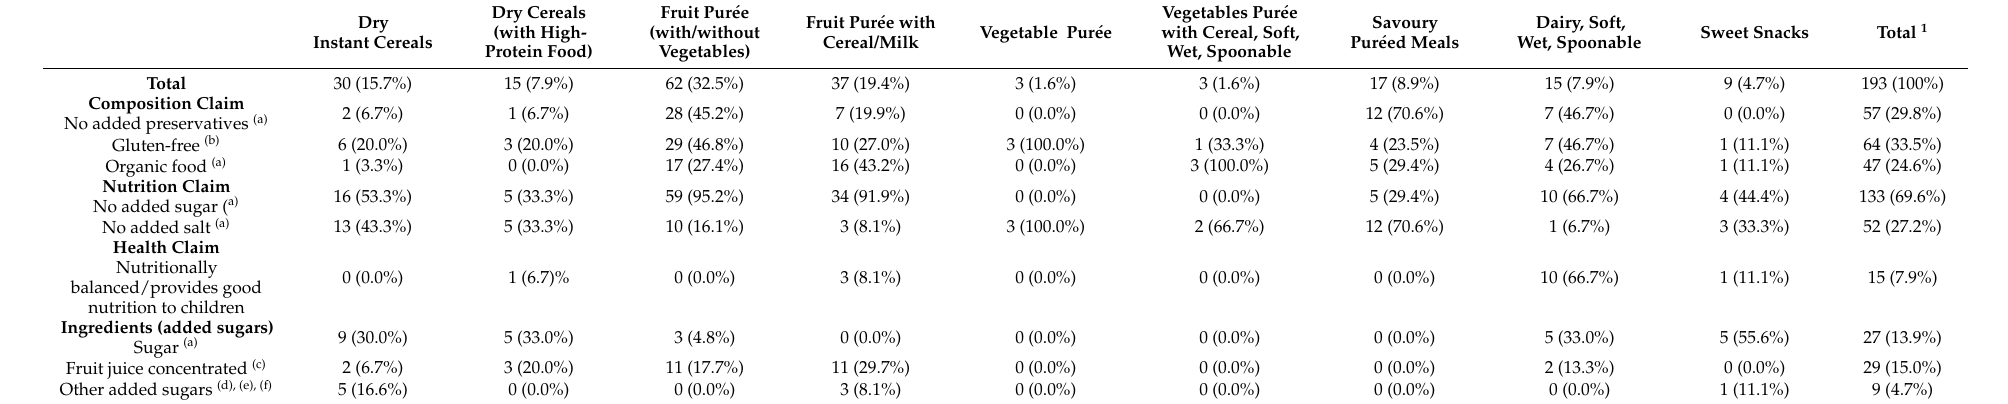
Table 4. Description of CACFs according to the presence of claims and presence of sugar-contributing ingredients (number ( n ) and percentage